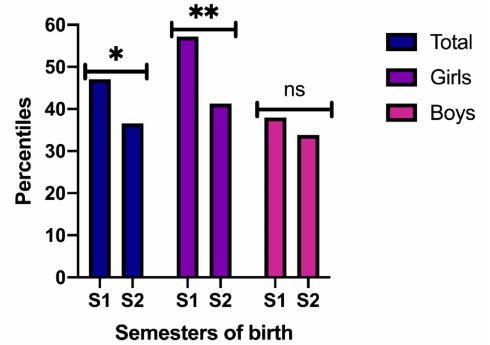
Figure 3. Percentiles according to gender and Semester of birth (S) and global. Note: * p < 0.007 dif- ferent between Semester 1 vs. Semester 2. ** p < 0.005 different between Semester 1 vs. Semester 2. ns p > 0.005 no significative